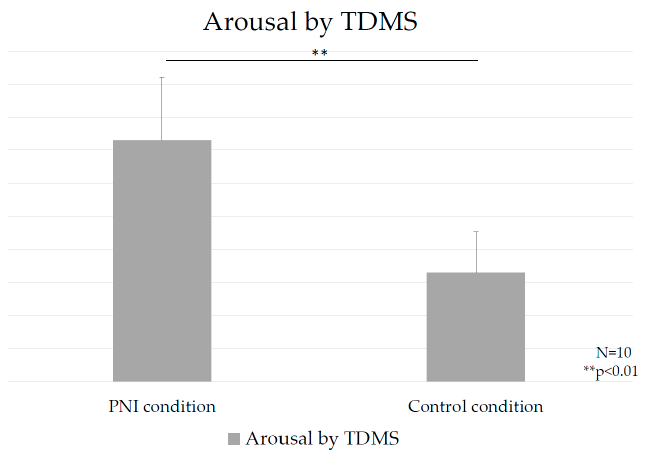
Figure 4. Comparing the amount of change in arousal by a Two ‐ Dimensional Mood Scale (TDMS) in Positive ‐ Negative Ions (PNI) and control conditions.